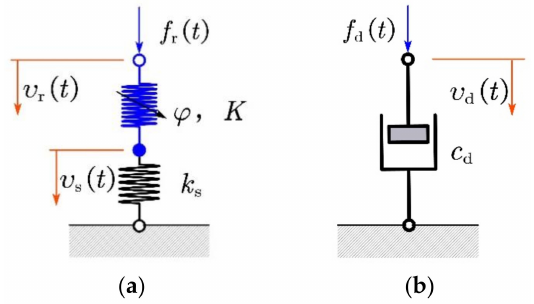
Figure 1. Model of dampers: ( a ) rubber damper; ( b ) viscous